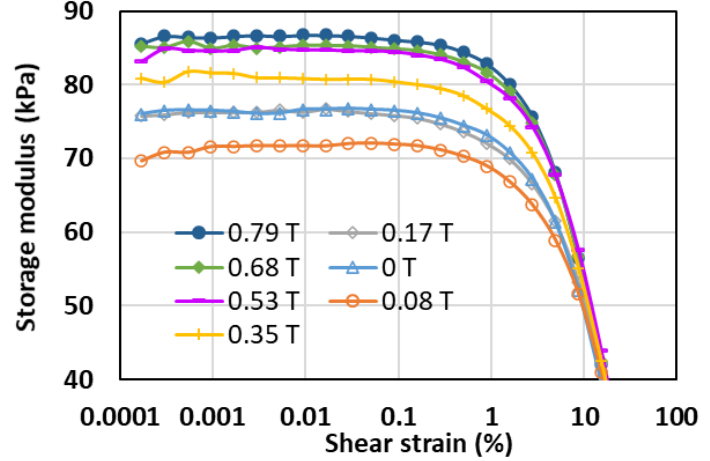
Figure 4. Storage modulus versus shear strain at different magnetic field strengths and frequency of 1 Hz.